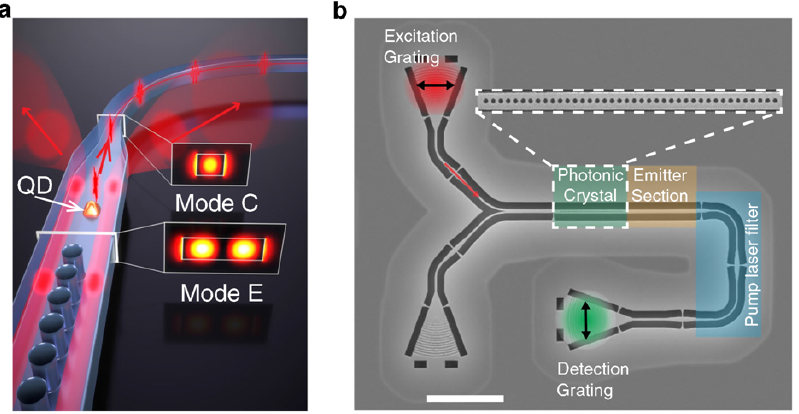
Figure 8. Waveguide-based excitation scheme. ( a ) Illustration of the mode filtering operation. ( b ) Scanning electron microscope image of the fabricated device (length of scale bar is 10 μ m) [47].